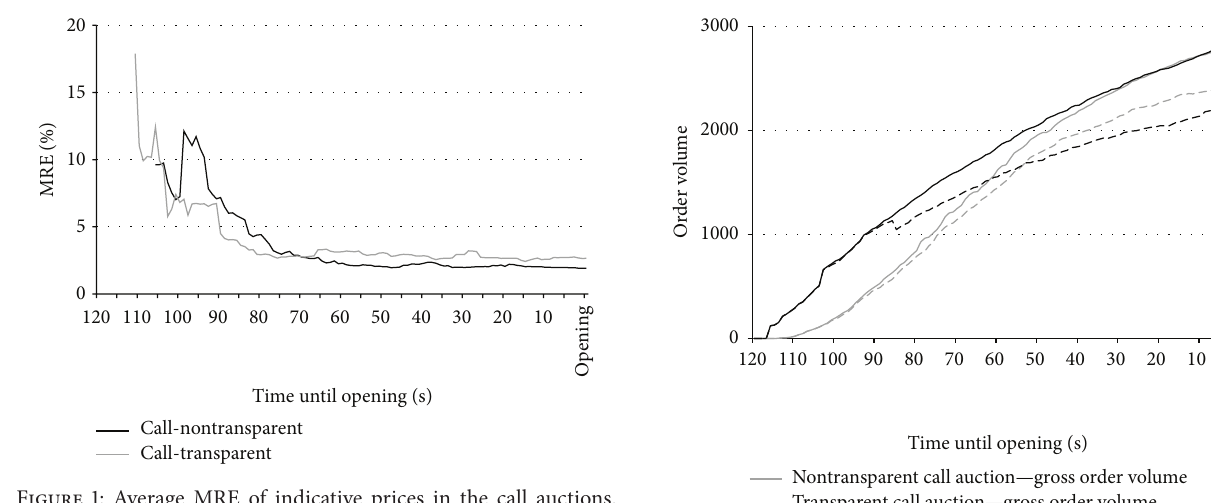
Figure 1: Average MRE of indicative prices in the call auctions. This figure displays the development of the average mean relative error (MRE) in the transparent and nontransparent call auctions over time.